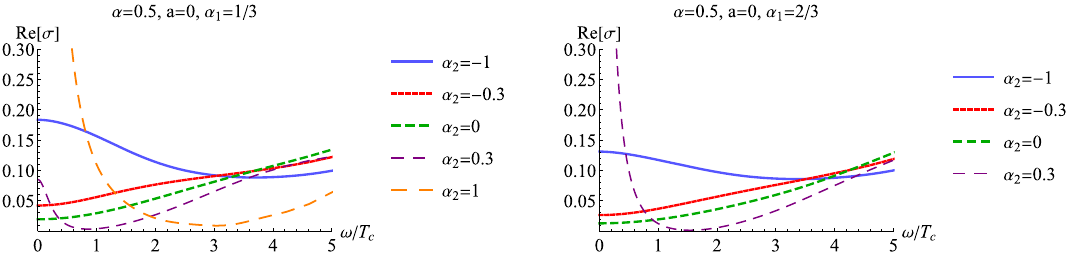
Fig. 9 The real part of conductivity as the function of the frequency with various α 2 for fixed α = 0 . 5 and a = 0 at T / T c ≈ 0 . 2. Left plot is for α = 1 / 3 and right plot for α = 2 / 3. Here we have abbreviated the two dimensionless quantities { T /μ,α/μ } to { T ,α } 1 1 the dashed red lines in Fig. 7 and also see Fig. 5). It